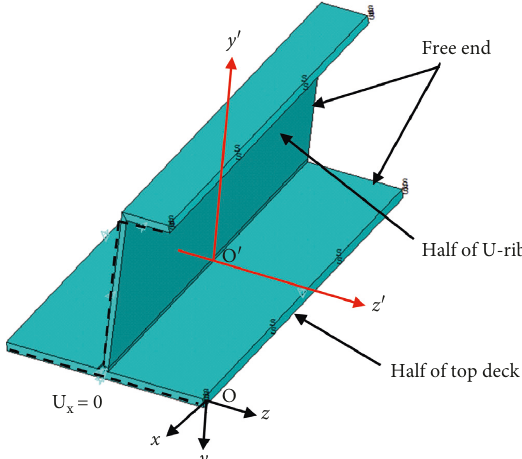
Figure 12: The finite element model and boundary conditions for welding